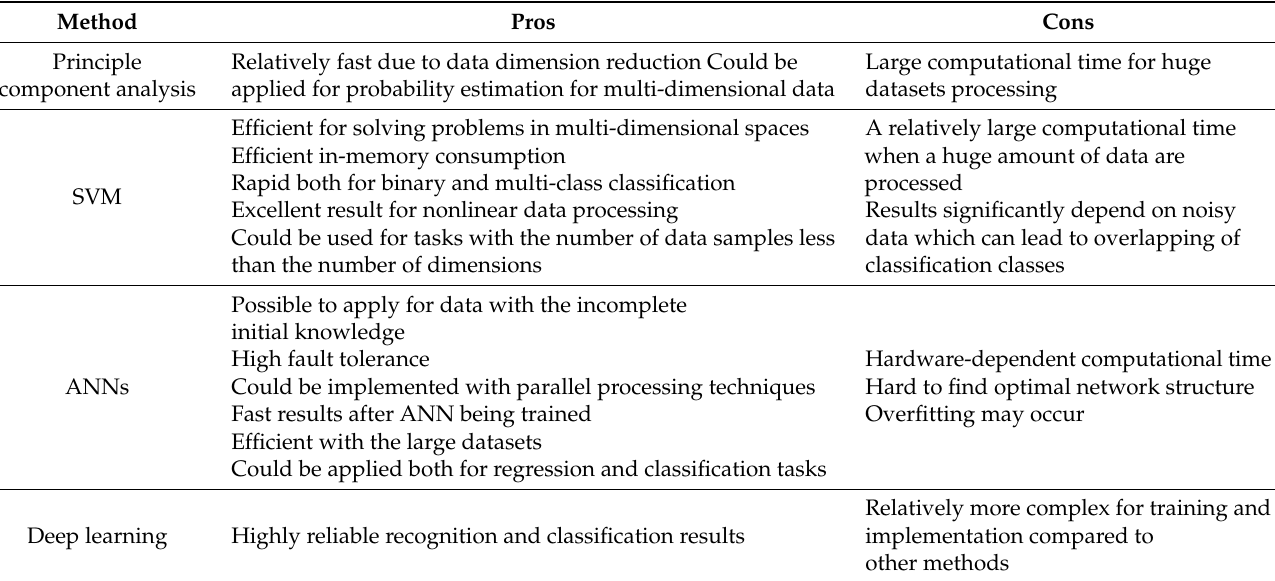
Table 2. Comparison of results analysis